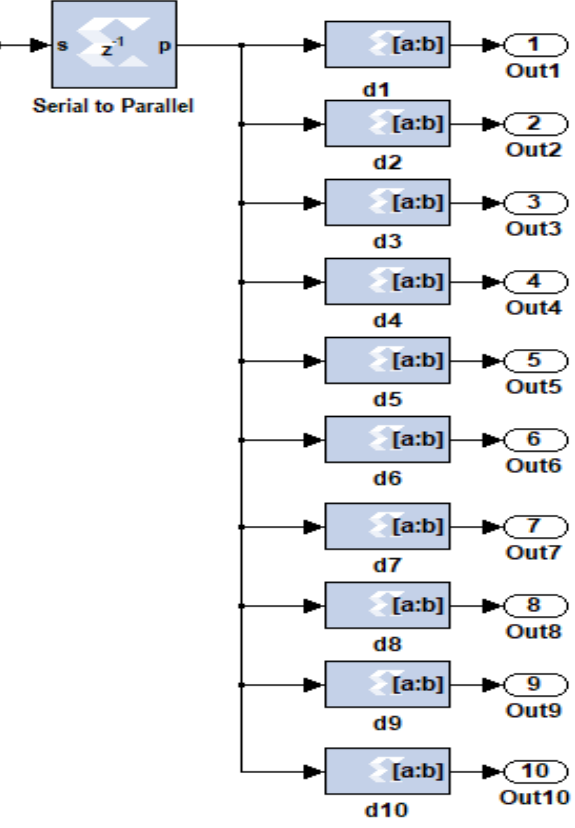
Fig. 4. Serial to Parallel converter Xilinx SG